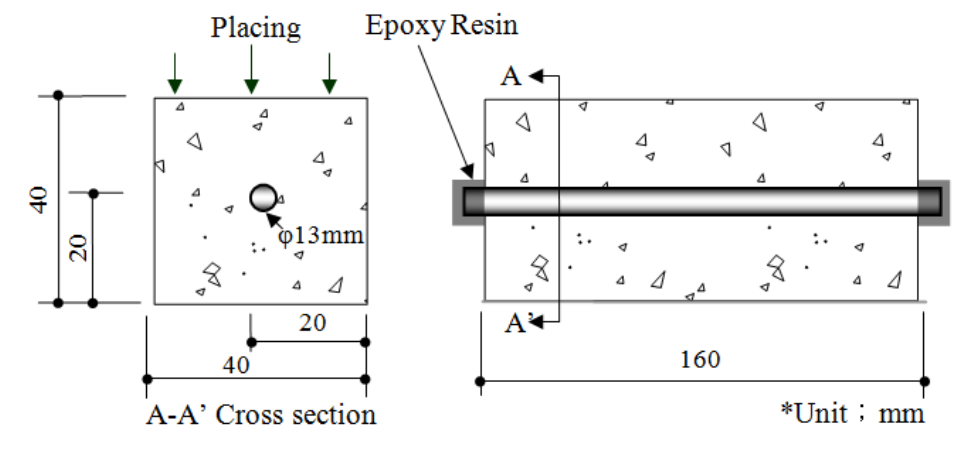
Figure 3. Details of test